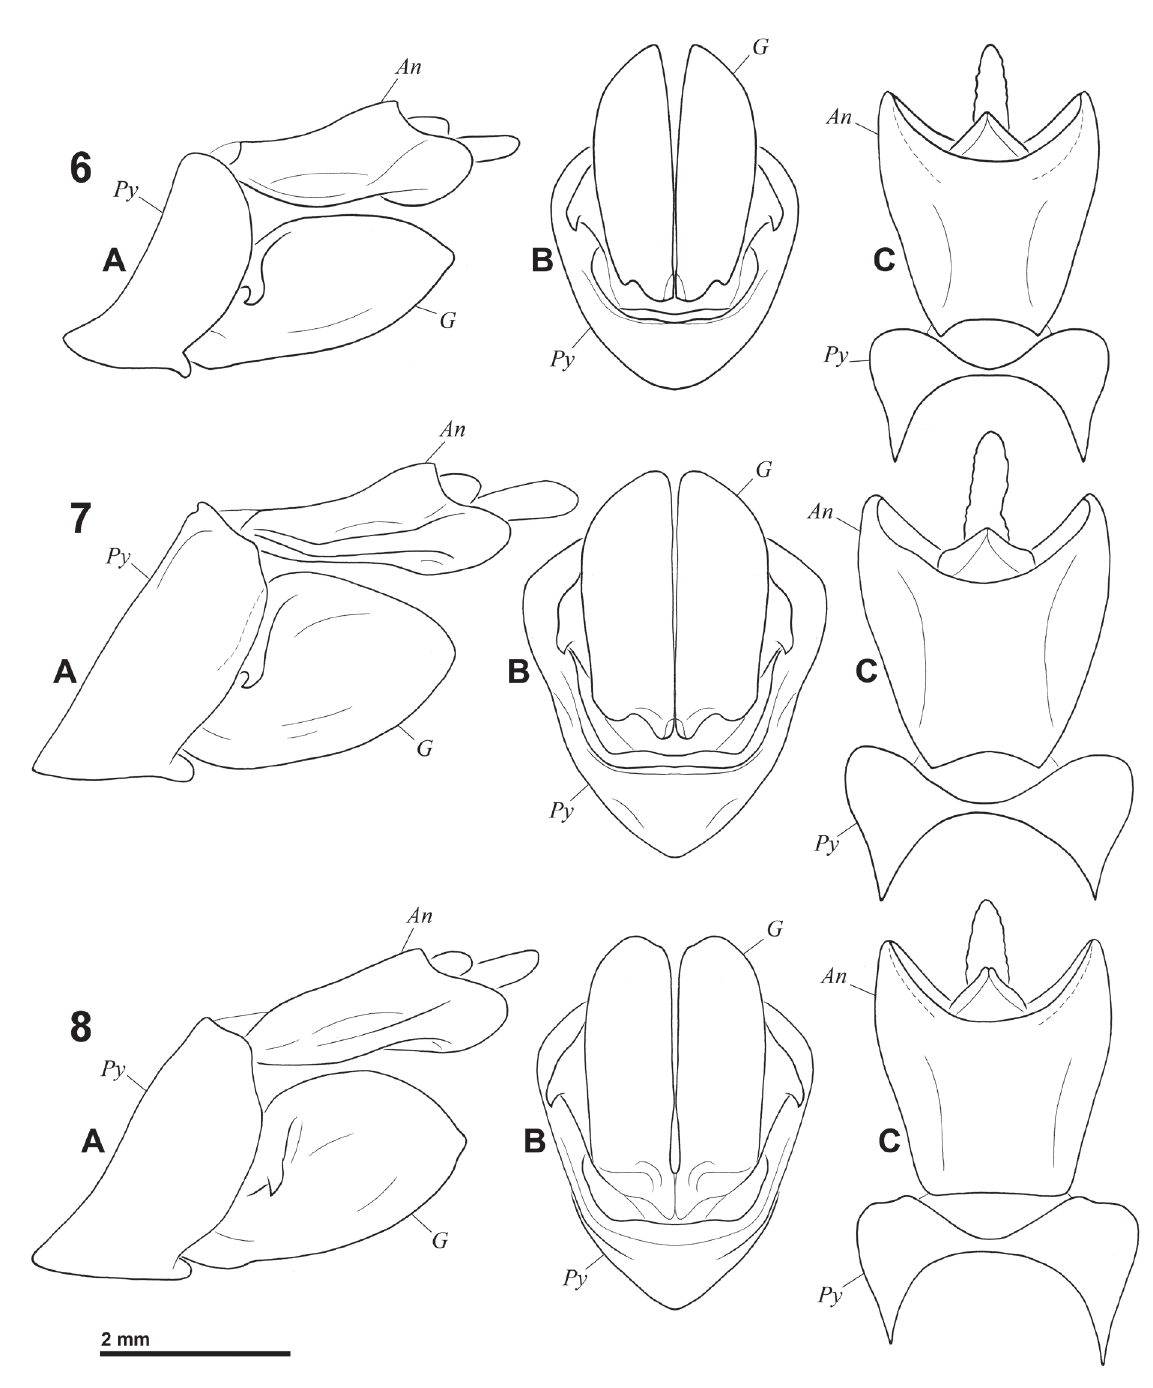
Figs 6–8. Pyrops clavatus group, male genitalia. 6 . Pyrops atroalbus (Distant, 1918) comb. nov. — 7 . P. clavatus (Westwood, 1839). — 8 . P. watanabei (Matsumura, 1913). A . Pygofer, anal tube and gonostylus, left lateral view. B . Pygofer and gonostyli, posteroventral view. C . Anal tube and pygofer, dorsal view. Abbreviations: An = anal tube; G = gonostylus; Py